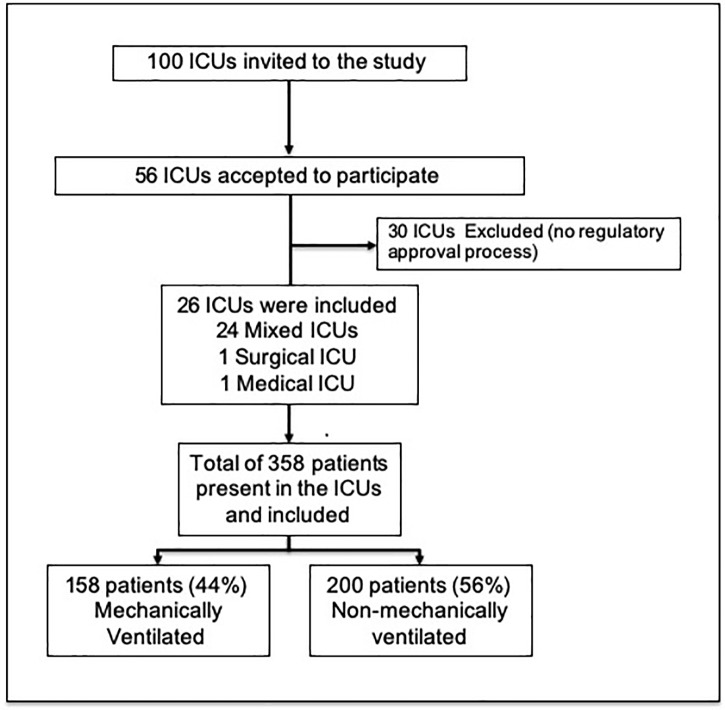
Study flowchart.